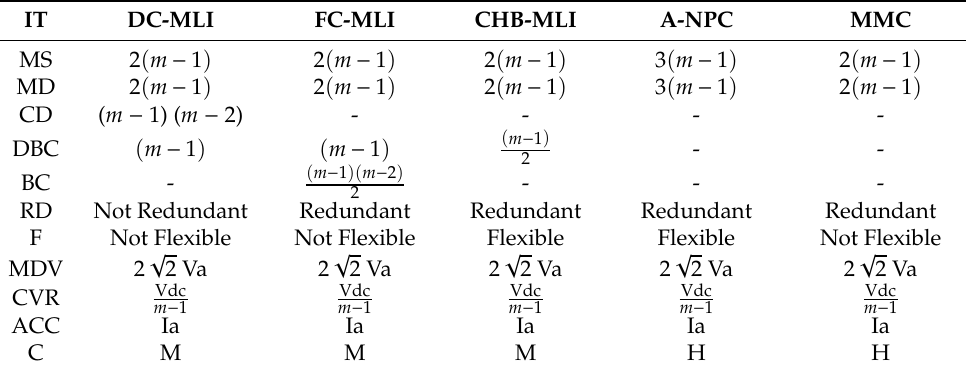
Table 7. Comparative assessment of various multilevel inverters.